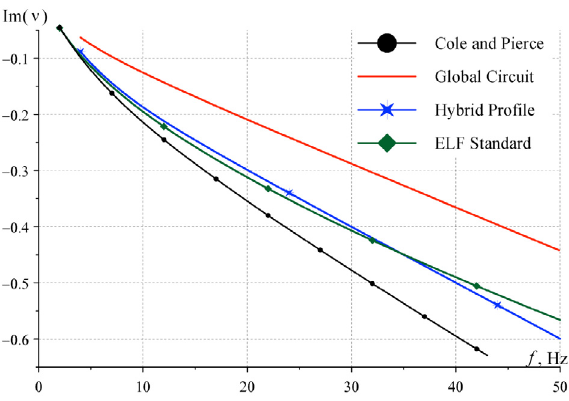
Figure 3. Imaginary part of the ELF propagation constant obtained with the full wave solution for the Cole and Pierce [1965] profile (black line with dots); profile based on the global circuit data (red smooth line); the hybrid profile (blue curve with stars). The ELF Standard reference model (Equations 10 to 13) is shown by the green curve with